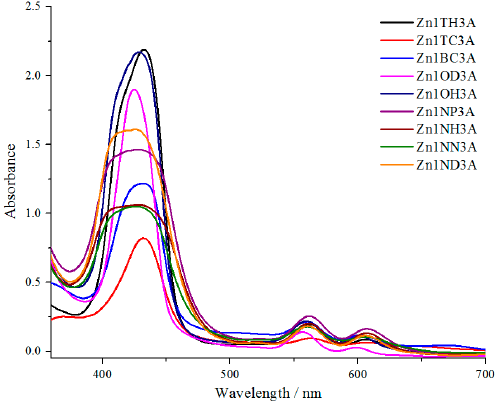
Figure 2. UV/Vis spectra of the 1D ‐π‐ 3A porphyrin sensitizers adsorbed on TiO 2 .